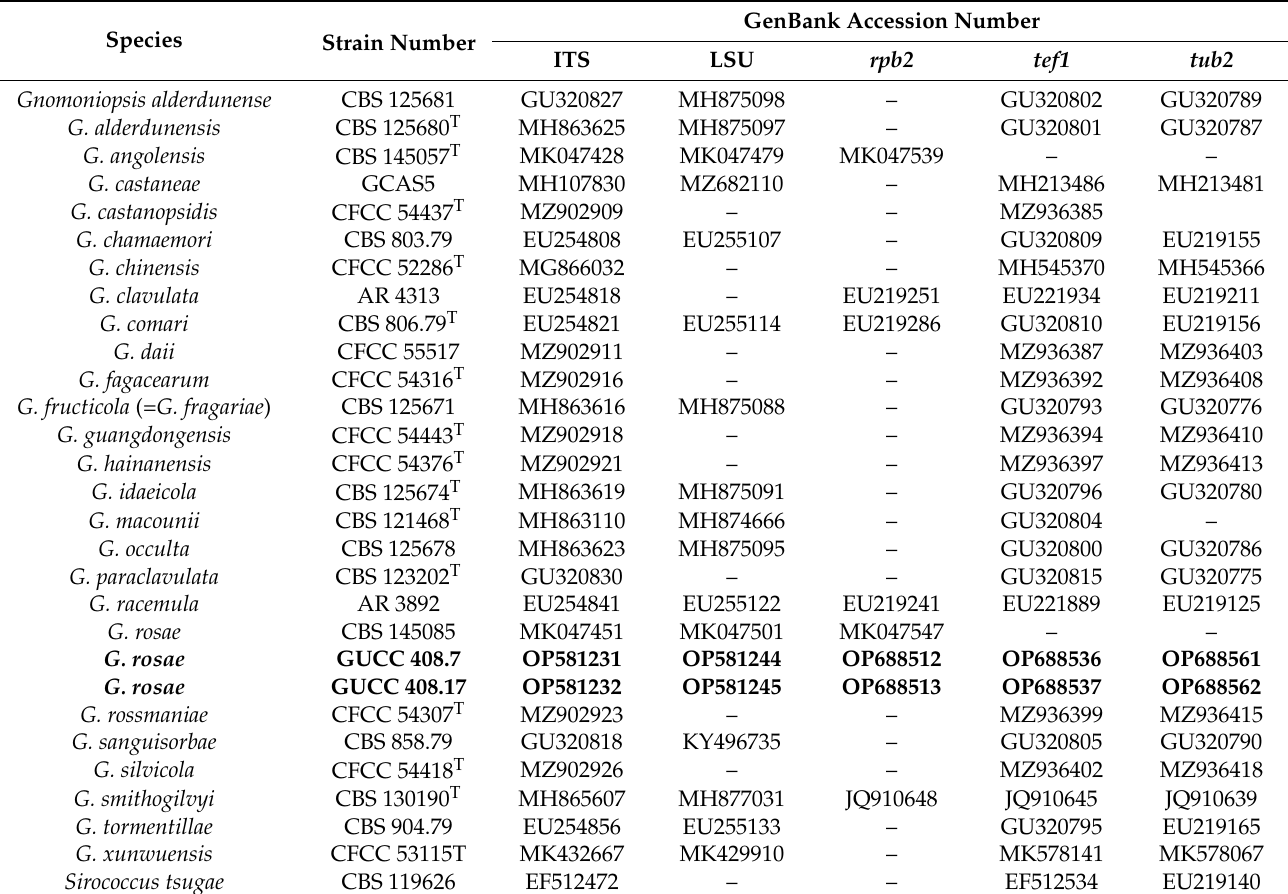
Table 4. Strains and their GenBank accession numbers used in the molecular phylogenetic analyses of Gnomoniopsis . Newly generated sequences are in bold. ( T ) = ex–type